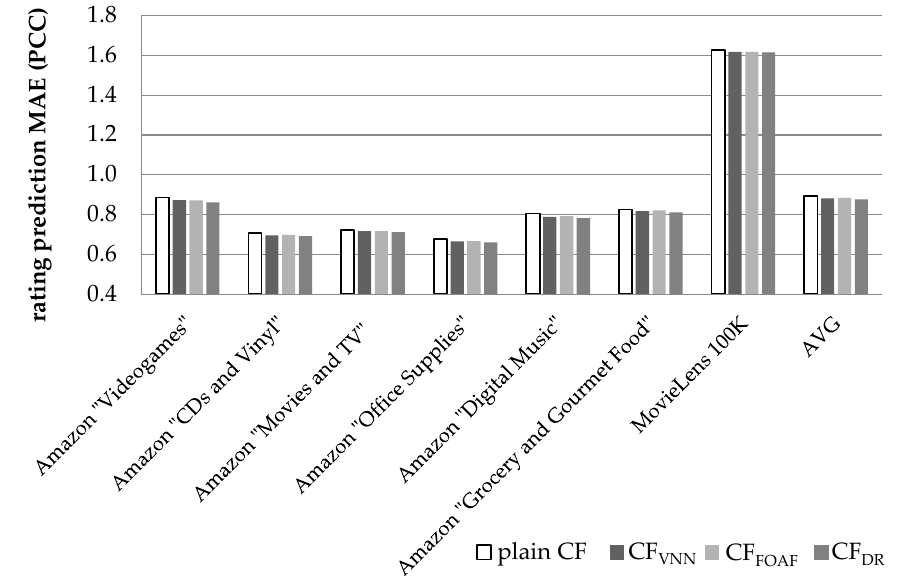
Figure 8. Rating prediction MAE for the datasets summarized in Table 4, when the PCC user similarity metric is used.